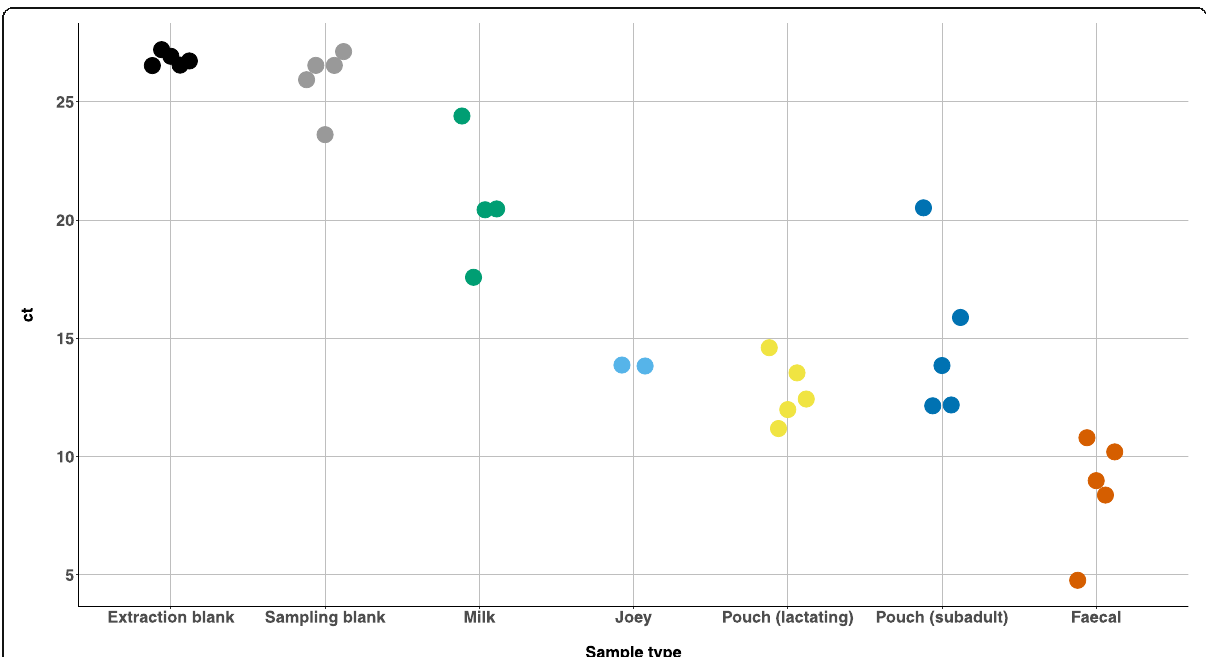
Fig. 3 Determination of SHNW sample microbial biomass using quantitative PCR (qPCR) of the V4 region of the 16S rRNA gene. Y-axis values represent the cycle of threshold (ct) values for each sample, with lower ct values representing higher 16S rRNA gene copy number and higher microbial biomass, and vice versa. Joey = joey skin